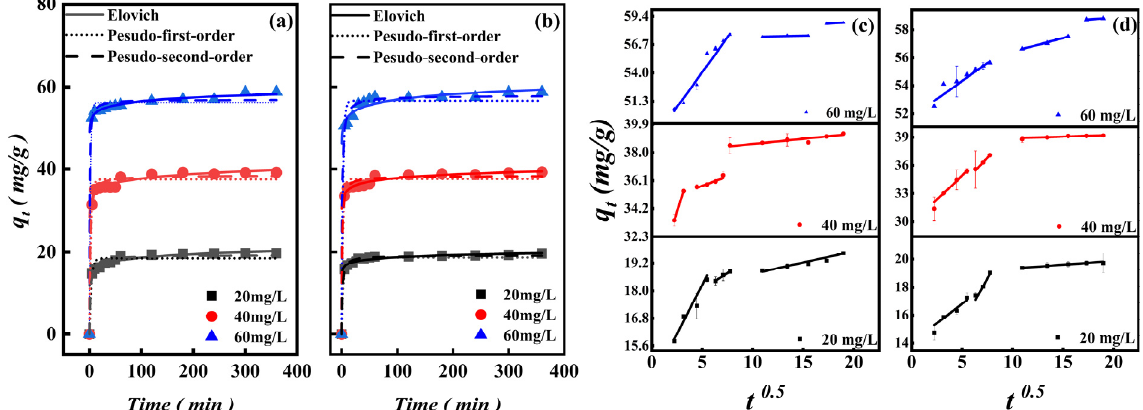
Figure 8. Non-Linear plots of the PFO model, PSO model, the IPD model and the Elovich model for the adsorption of MB onto BC ( a , c ) and Fe 3 O 4 -MOS ( b , d ) composites at 20, 40 and 60 mg/L dye solutions. Table 1. Kinetic parameters of PFO model, PSO model, Elovich model and IPD model. Model